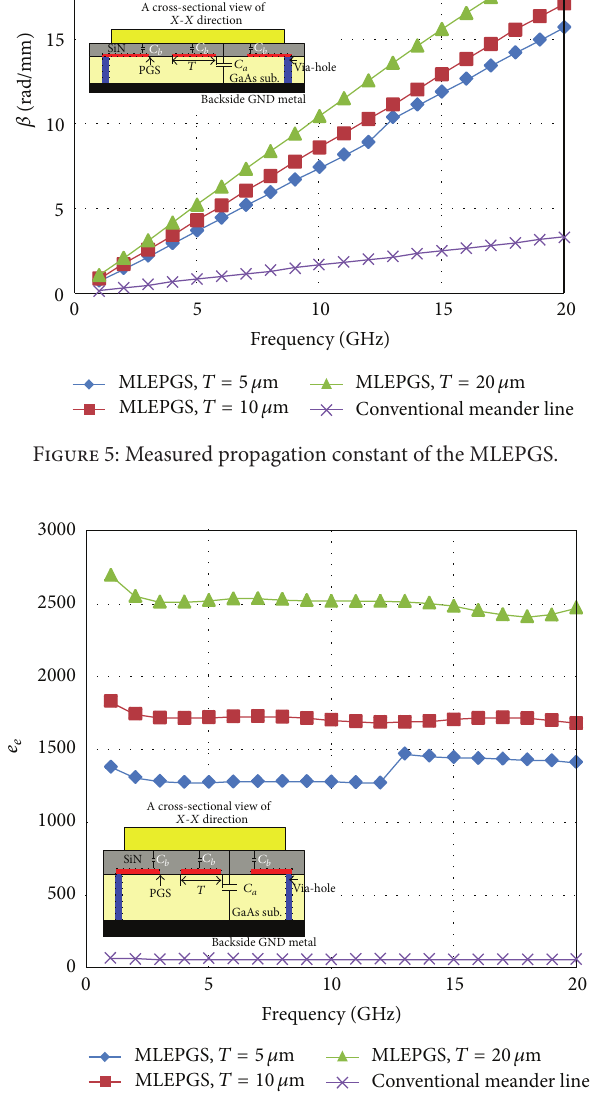
Figure 6: Measured effective permittivity of the